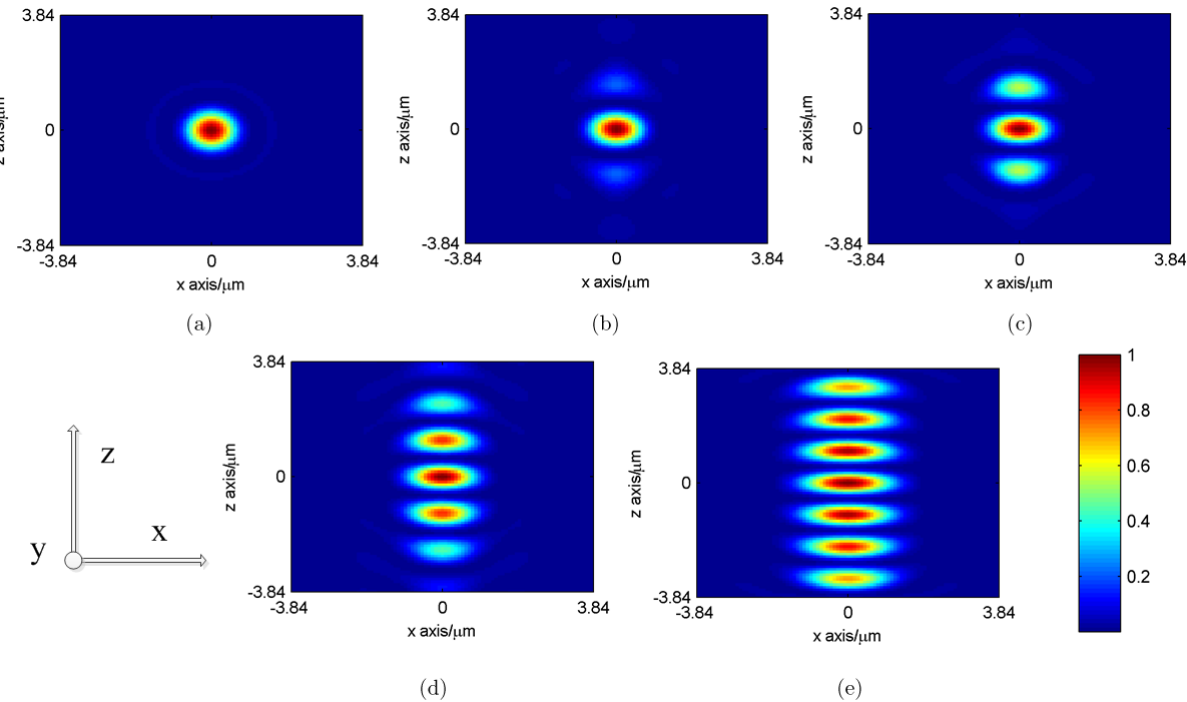
Fig. 2. (a) – (e) The point spread function of D-aperture for di®erent values of factor d / r . The values of factor d / r are set as 0, 0.4, 0.8, 1.2 and 1.6.